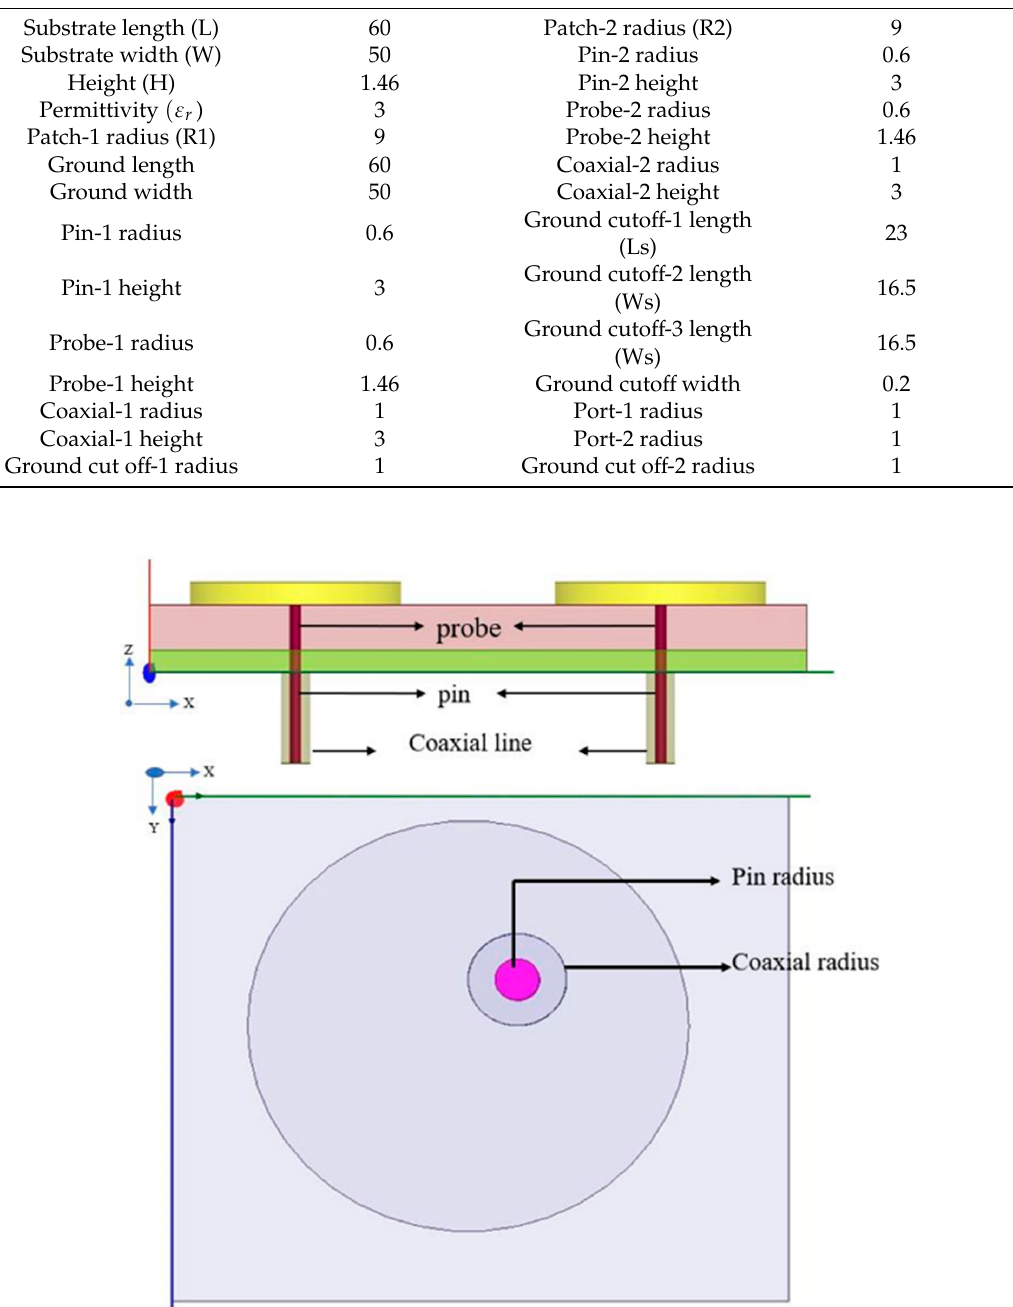
Table 1. Dimensions of the proposed MIMO antenna.